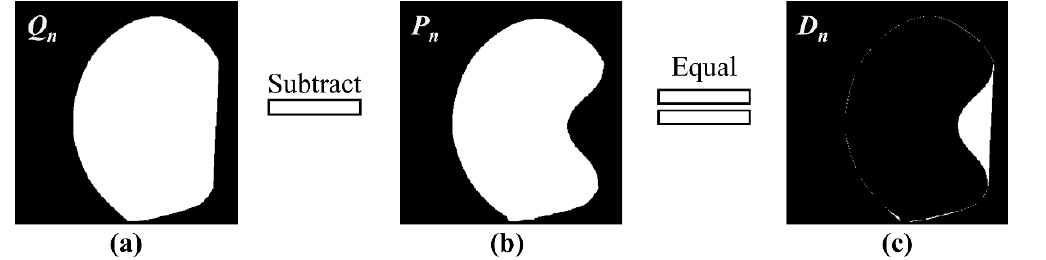
Figure 4. The principle of solving the 2D convex hull. ( a ) Results of 2D convex hull results; ( b ) segmentation of the uncalculated portion of the convex hull; ( c ) the subtraction result.